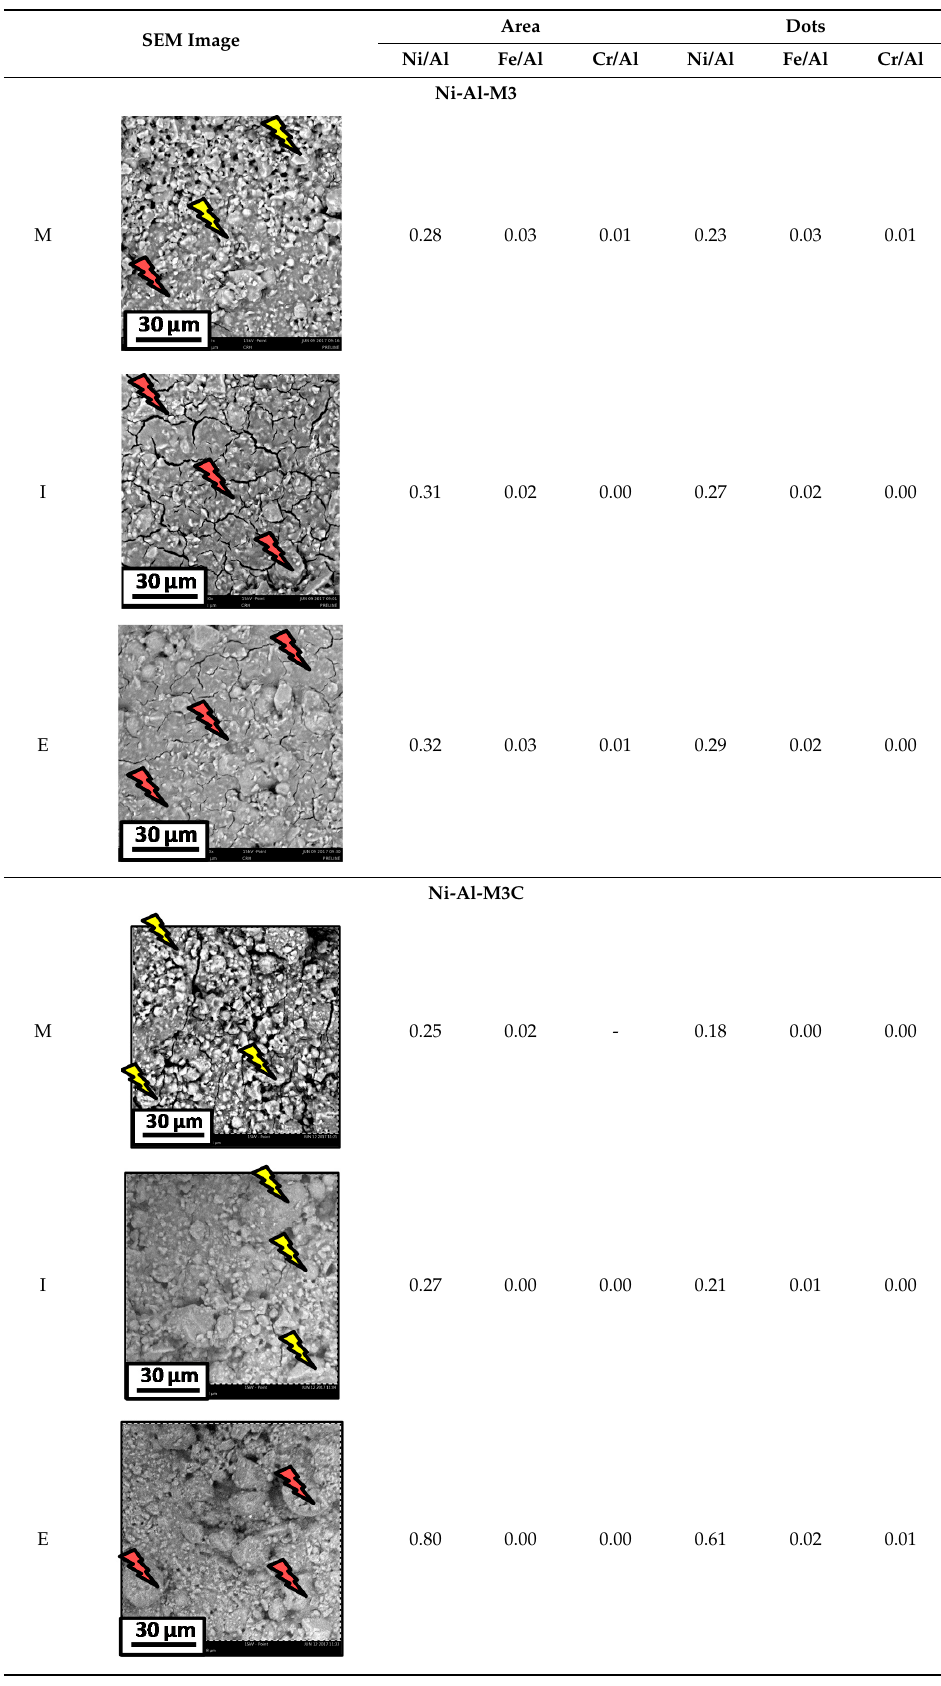
Table 2. SEM micrographs and elemental analysis of the Ni-Al-M3 and Ni-Al-M3C structured catalysts.